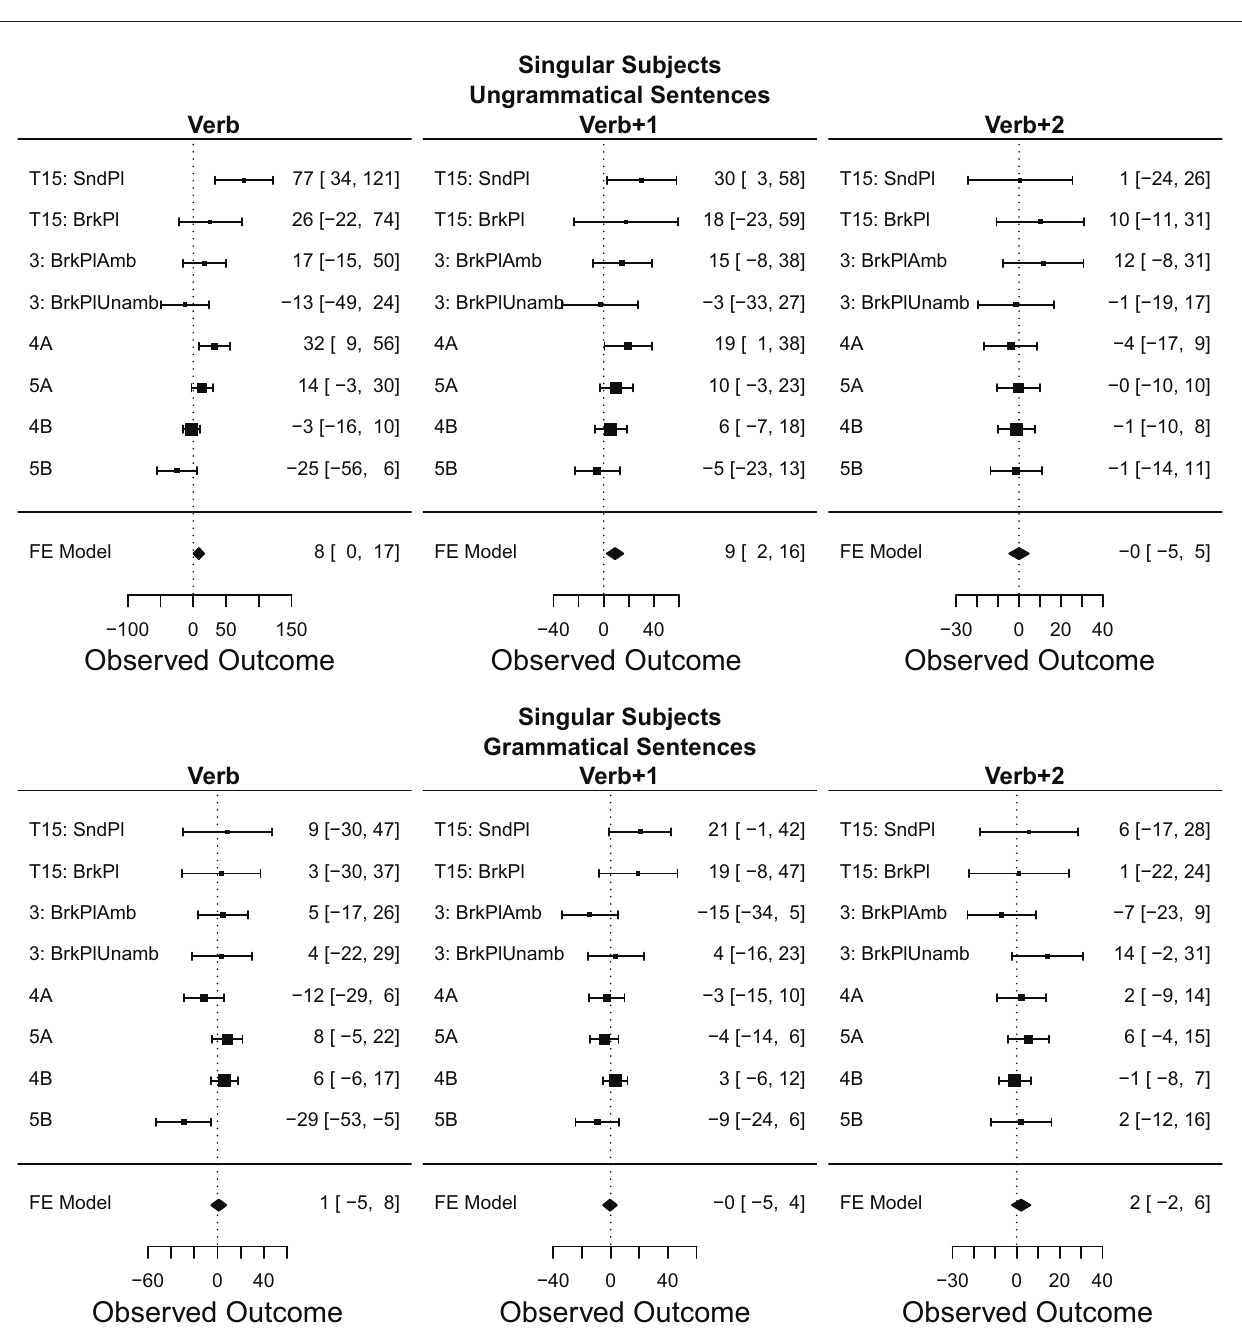
original experiment 5A was in the other direction.